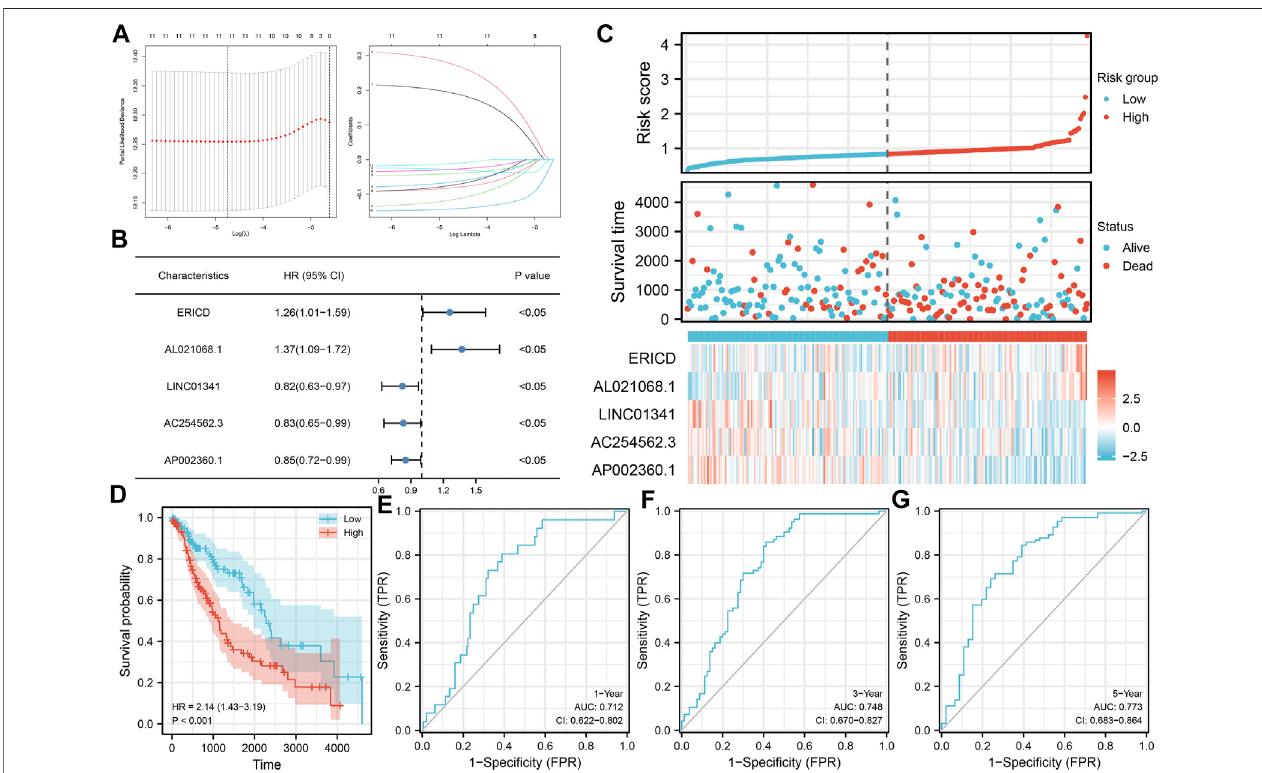
FIGURE 2 | Construction of the prognosis model. (A) LASSO regression analysis was used for dimension reduction; (B) ERICD, AL021068.1, LINC01341, AC254562.3, and AP002360.1 were identi fi ed for prognosis model construction; (C) Overview of our model in the training cohort; (D) Kaplan – Meier survival curve was performed to indicate the prognosis difference between high- and low-risk groups; (E – G) ROC curve of 1-, 3-, and 5-years.